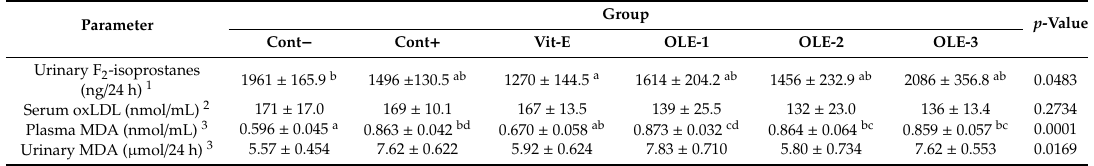
Table 4. Plasma and urinary markers of oxidative stress in piglets fed the experimental diets ( n = 8 /